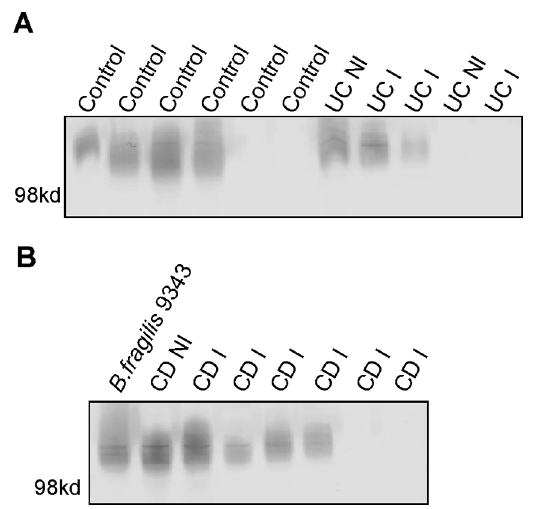
Figure 5. PSA analysis of B.fragilis isolates. A Western blot of PSA from B. fragilis isolates grown in vitro after isolation from control, CD and UC (inflamed (I) a non-inflamed (NI) biopsies. Panel A: Lanes 1–6 contain B. fragilis isolates from the biopsies control subjects (4, 6, 13, 34, 68, and 1). Lanes 7–8 contain isolates from non-inflamed and inflamed biopsies from subject 23 with UC. Lanes 9–11 contain isolates from inflamed and uninflamed biopsies from subjects with UC: 32, 29 and 77. Panel B: Lane 1 contains B. fragilis type strain 9343 as a positive control. Lanes 2 and 3 contain isolates from a non-inflamed and then an inflamed biopsy from subject 47 with CD. Lanes 4–8 contain B. fragilis isolates from inflamed biopsies of subjects 26, 56, 64, 14, and 85 with